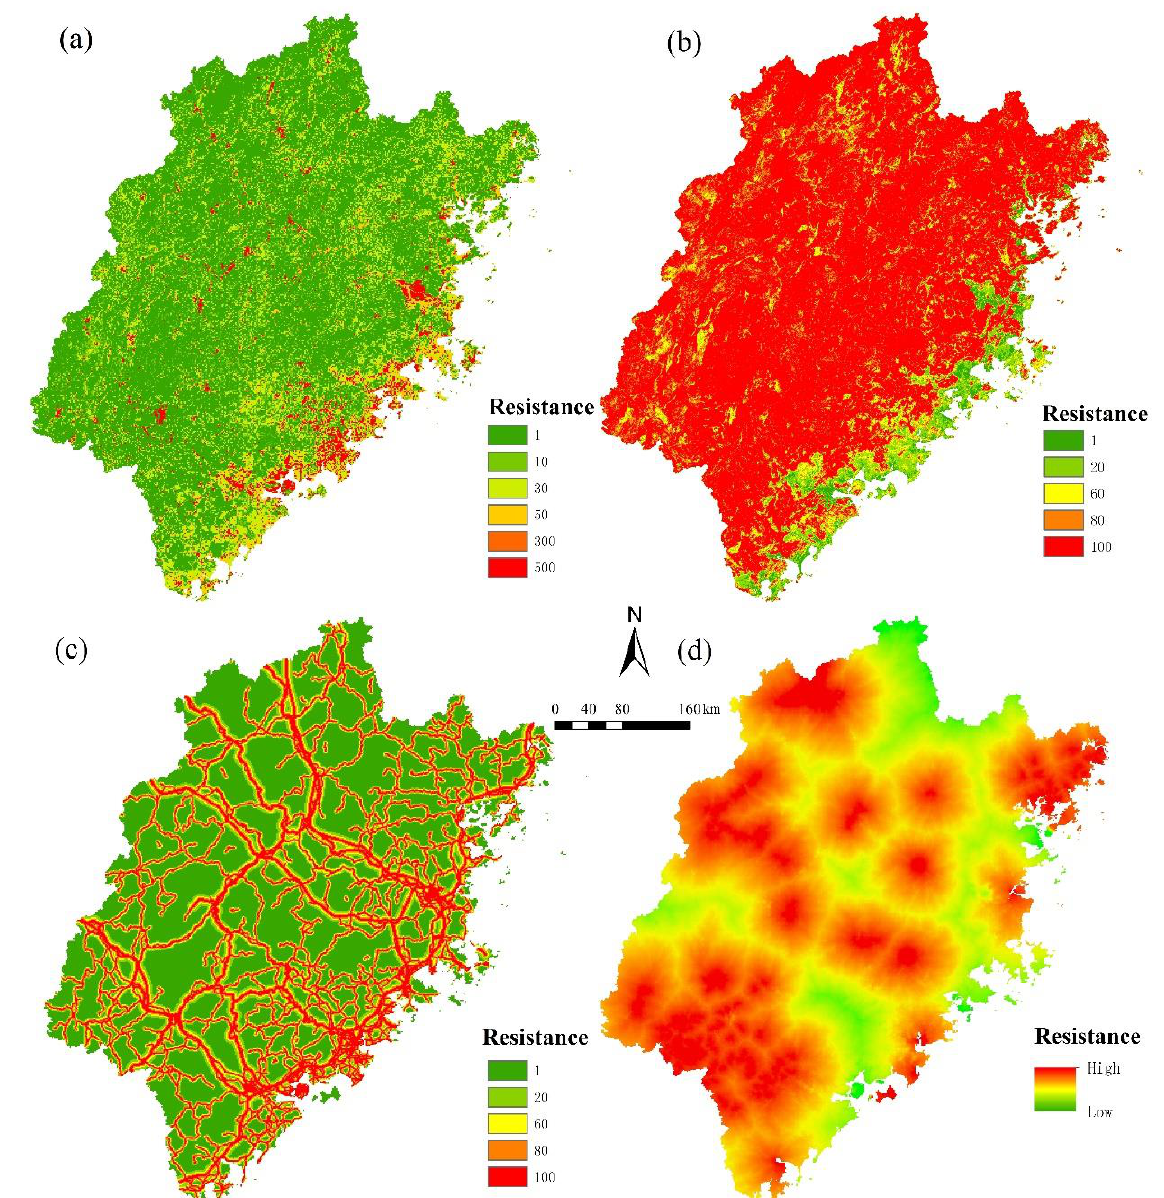
Figure 5. Single factor resistance surfaces and minimum cumulative cost resistance surfaces. ( a ) re- sistance surface of land-cover types, ( b ) resistance surface of the relief amplitude of land surfaces, ( c ) resistance surface of roads, and ( d ) minimum cumulative cost resistance surfaces. Table 4. Area proportion of the types of green spaces in ecological corridors of Fujian.